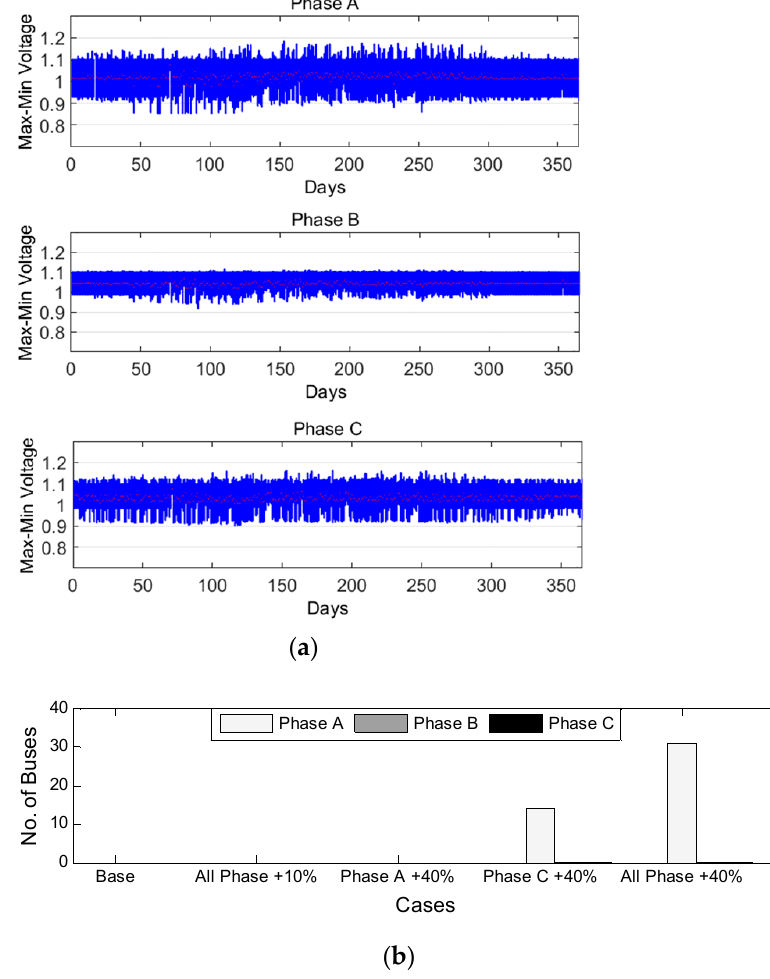
Figure 11. Bus voltage assessment on violation of limits. ( a ) Maximum and minimum voltage of the